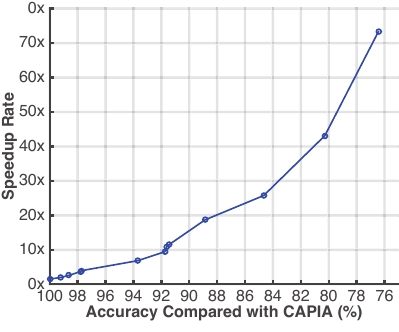
Figure 8. Speedup Rate with Different Approximation Power comparison candidates Comp qL and Comp h are com- puted with ( m L 1 + 1) DOT m + ( m KL + 1) DOT m L 1 (cid:48) ations and ( m + 1) DOT + ( m KL + 1) DOT m (cid:48) L 1 m L 1